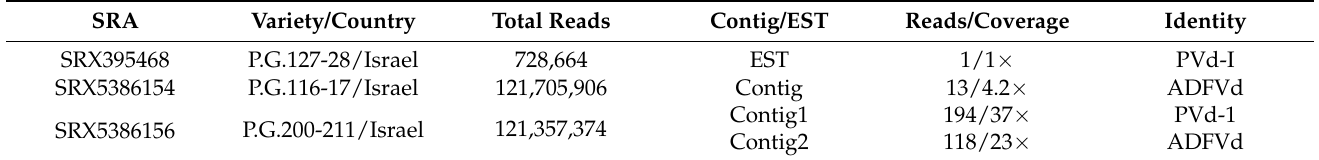
Table 1. Properties of the analyzed pomegranate SRAs and of the viroid EST/contigs identified. SRA